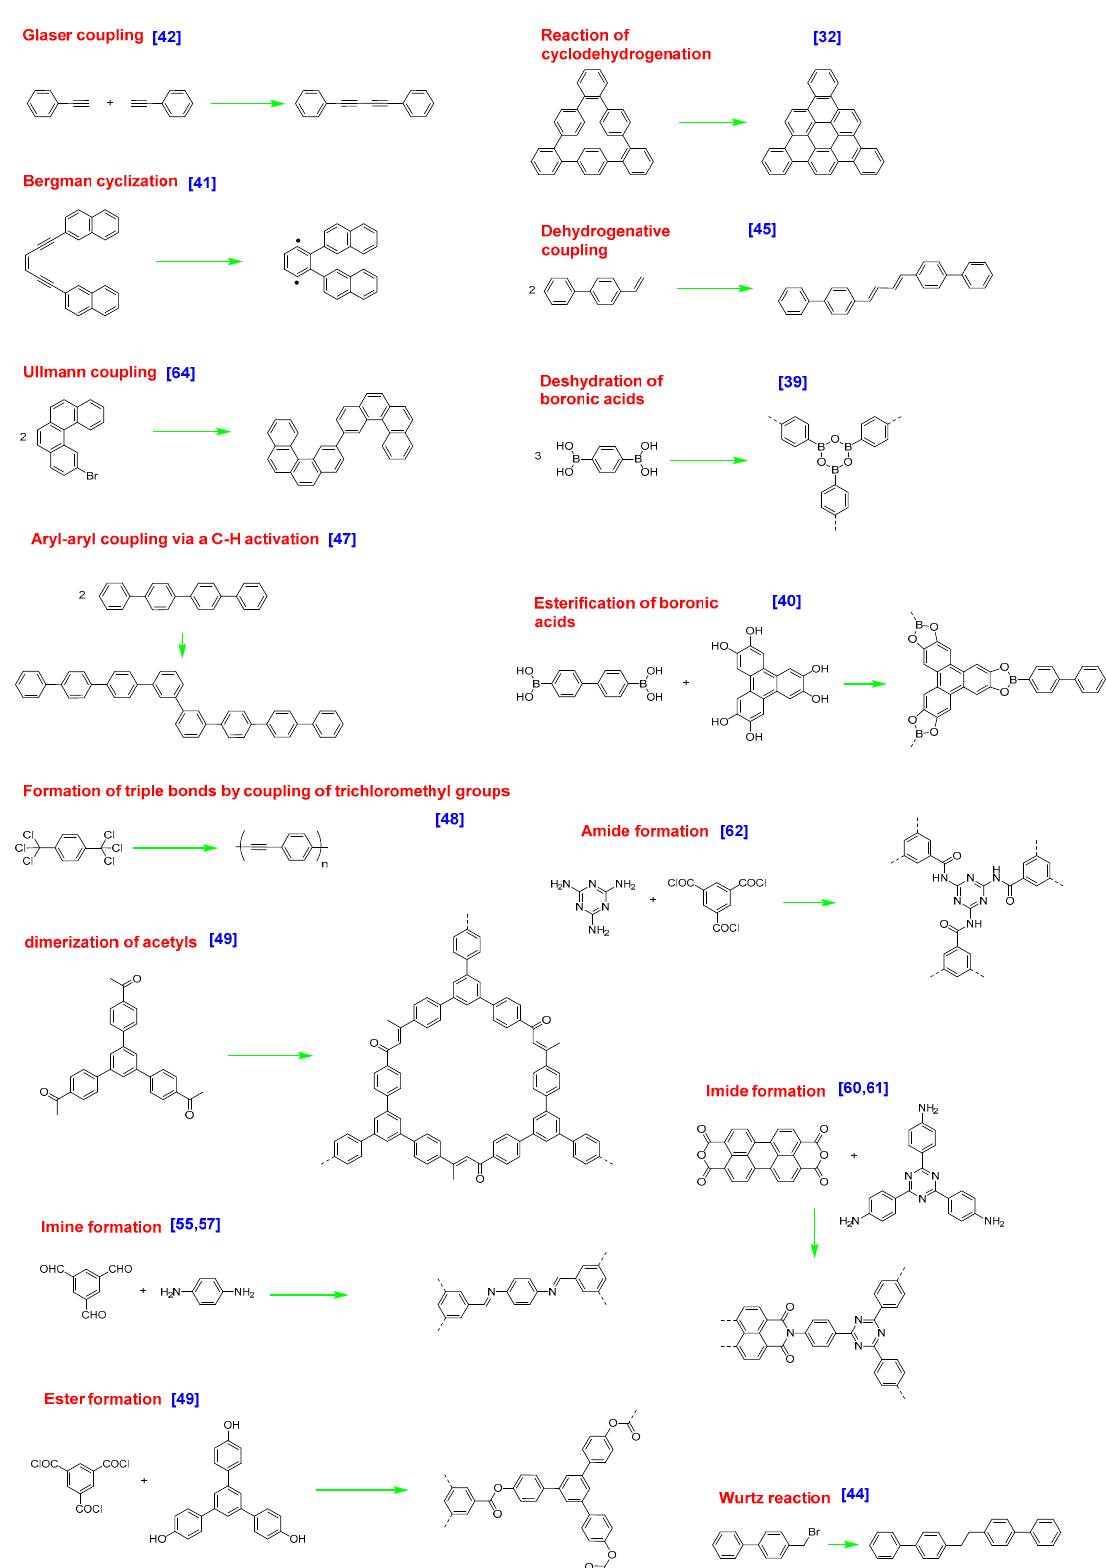
Figure 3. Examples of common on-surface reactions reported in the literature.